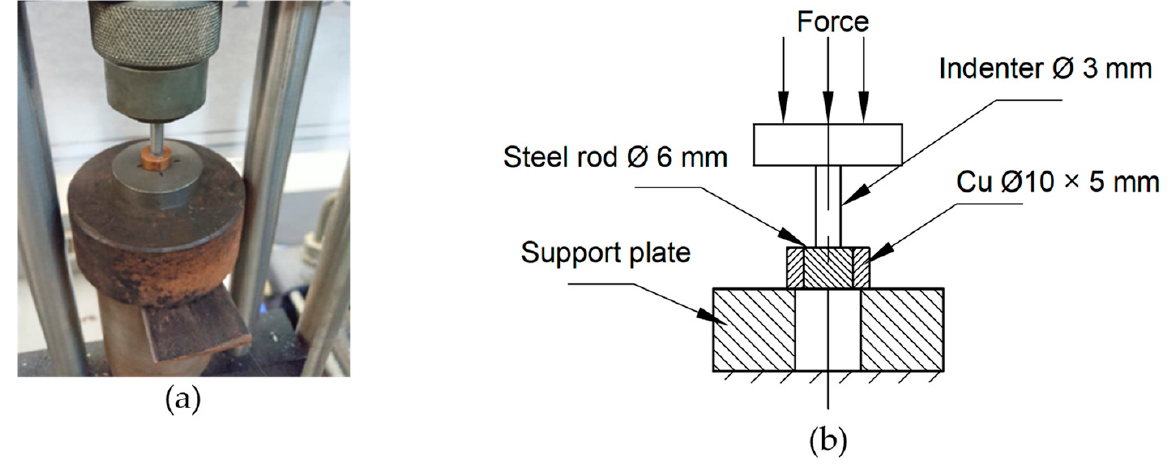
Figure 2. ( a ) Photograph of the actual push-out test set up; ( b ) diagrammatic sketch of the push-out test set up.